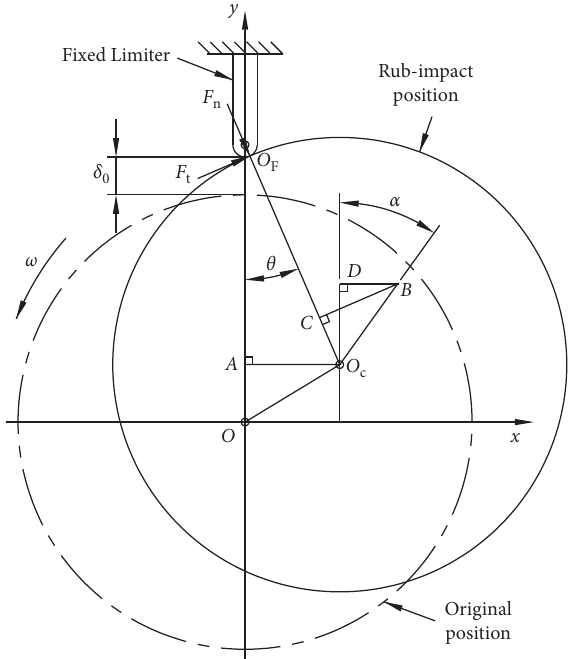
Figure 5: Schematic diagram of rub-impact force between the disk and fixed